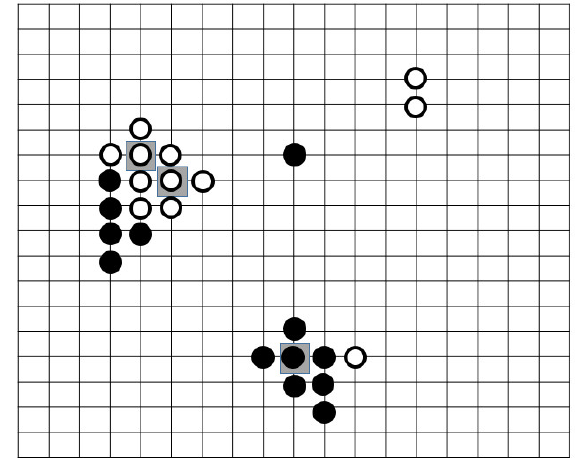
Figure 4: A configuration of the Go game after sev- eral moves (payoffs defined on the basis of a standard definition of rough